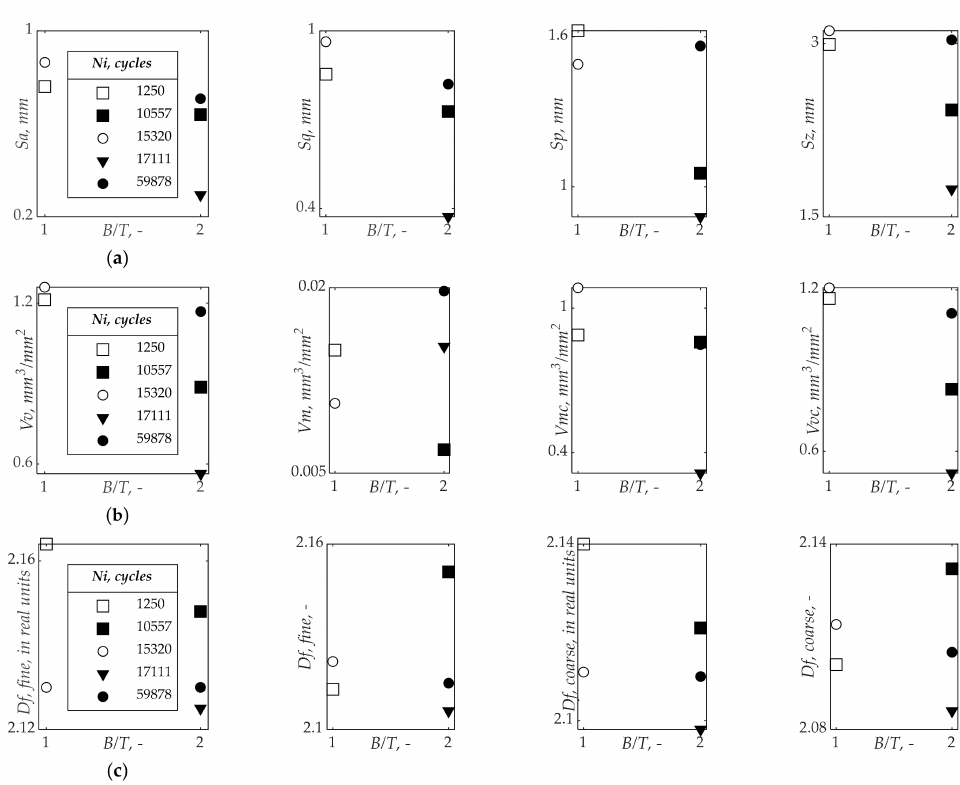
Figure 3. Results of fracture surface measurement: ( a ) Sx parameters; ( b ) Vx parameters; and ( c ) Df parameters grouped by N i .